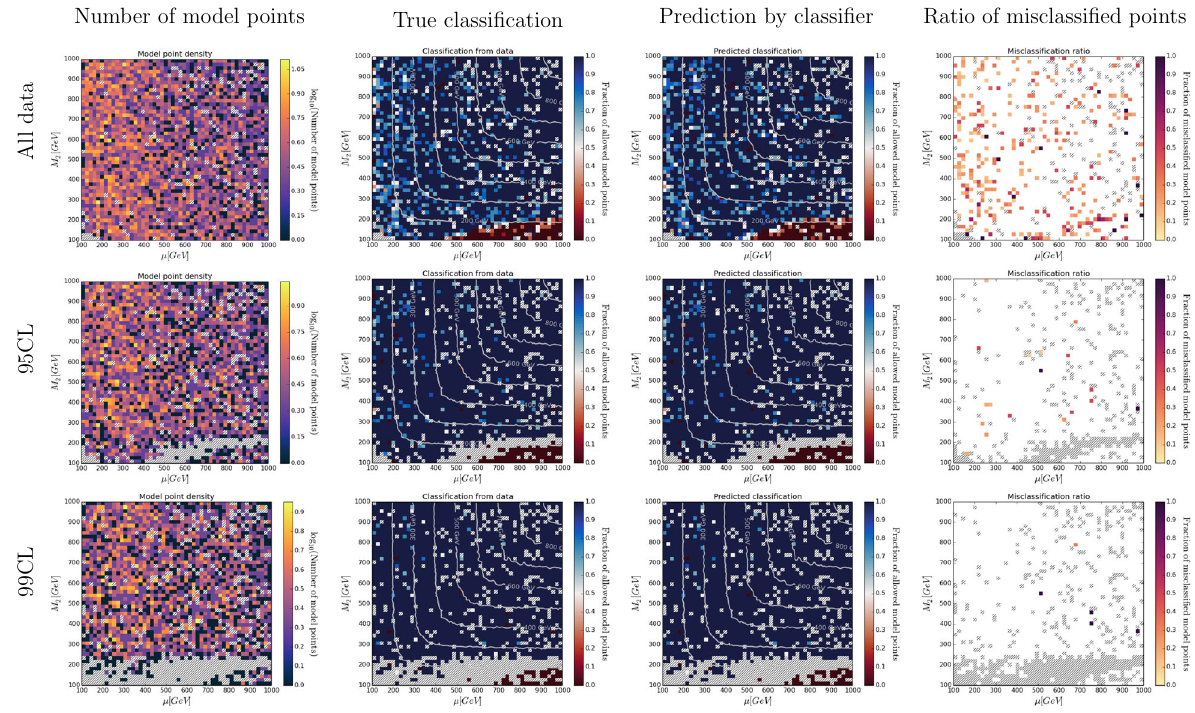
column indicates the fraction of allowed data points. The last column Fig. 12 Color histograms for a projection of the 19-dimensional pMSSM parameter space on the M 2 – μ plane after imposing the con- shows the fraction of misclassified points. The dashed bins contain straints on the soft breaking parameters summarized in Table 8 ( right ). The contours denote the mass of χ 0 . The color in the second and third 1